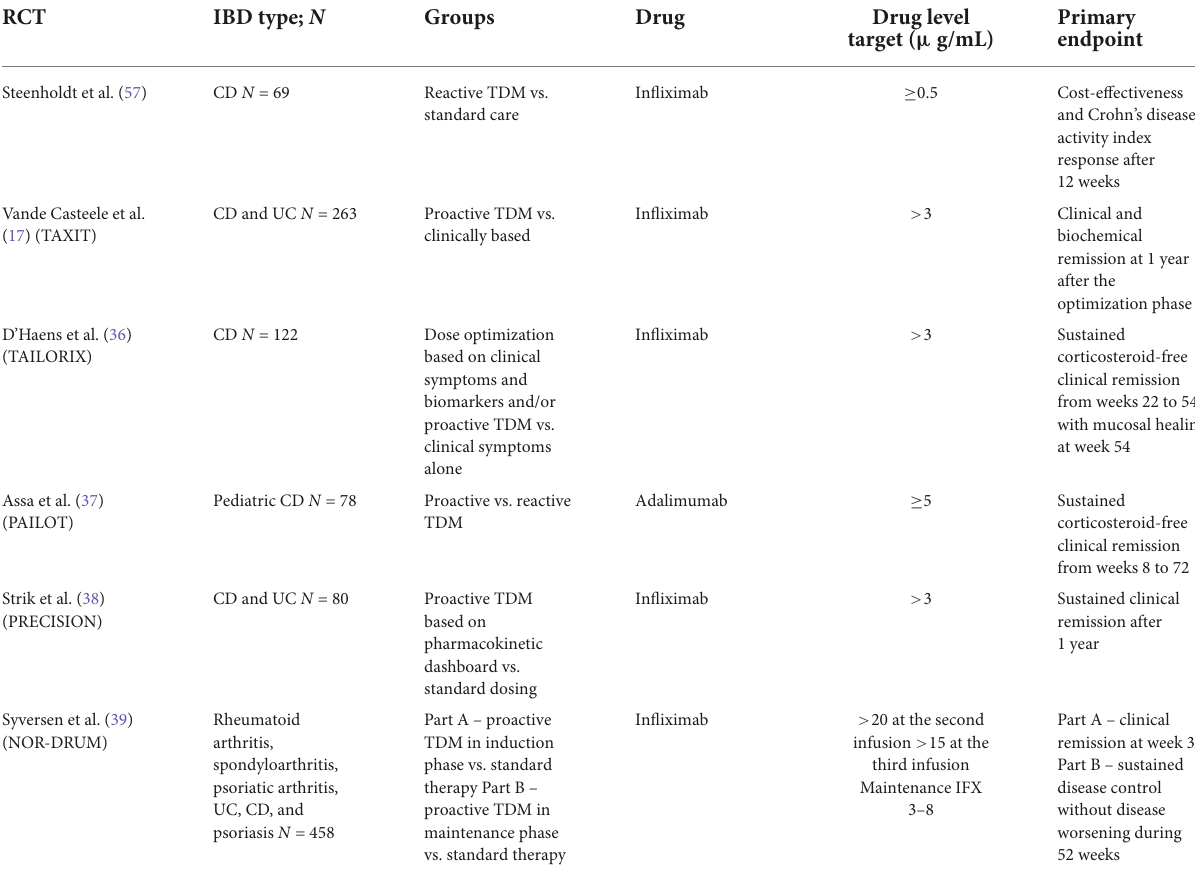
TABLE 3 Summary of RCTs assessing the role of TDM in